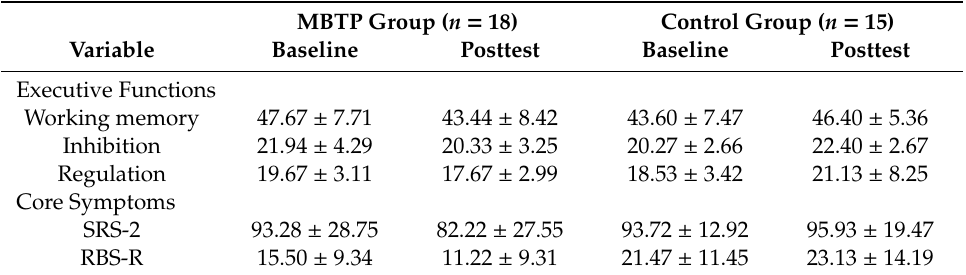
Table 2. Analysis of MBTP and Control groups for executive functions and core symptoms variables (M ±